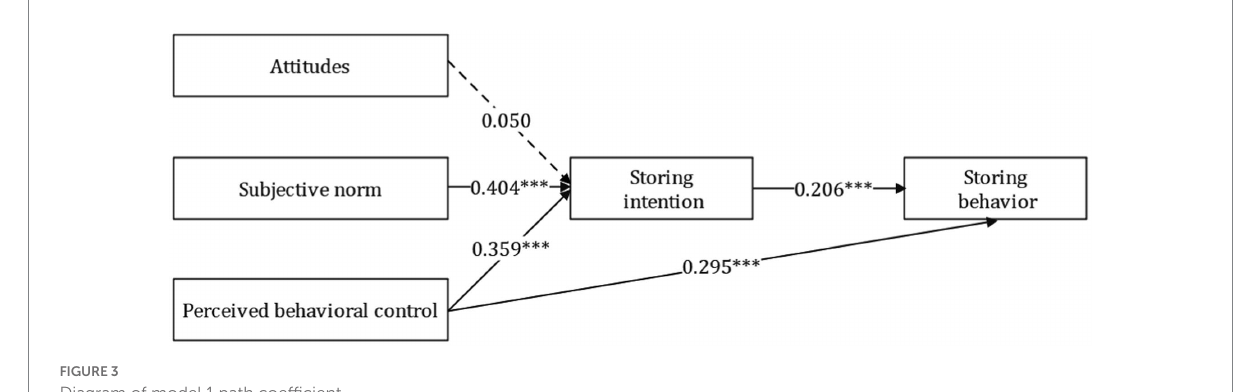
FIGURE 3 Diagram of model 1 path coefficient.